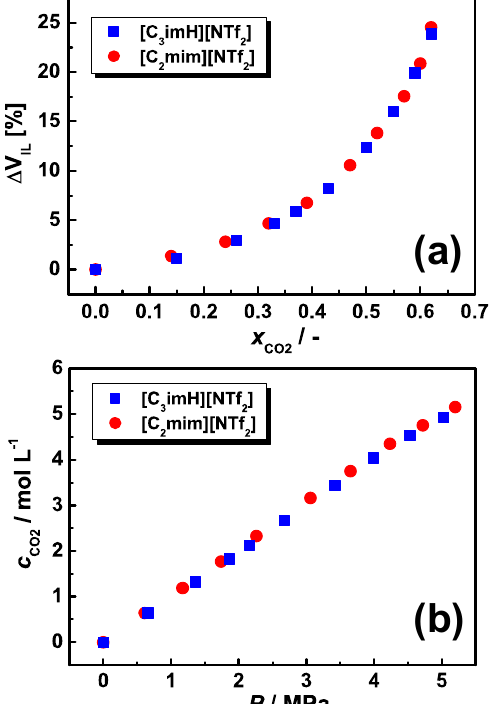
Figure 4. ( a ) Volume expansion of IL as a function of mole fraction of dissolved CO 2 and ( b ) molarities of dissolved CO 2 as a function of the pressure of CO 2 for PIL [C 3 imH][NTf 2 ] and AIL [C 2 mim][NTf 2 ] at 30 °C.